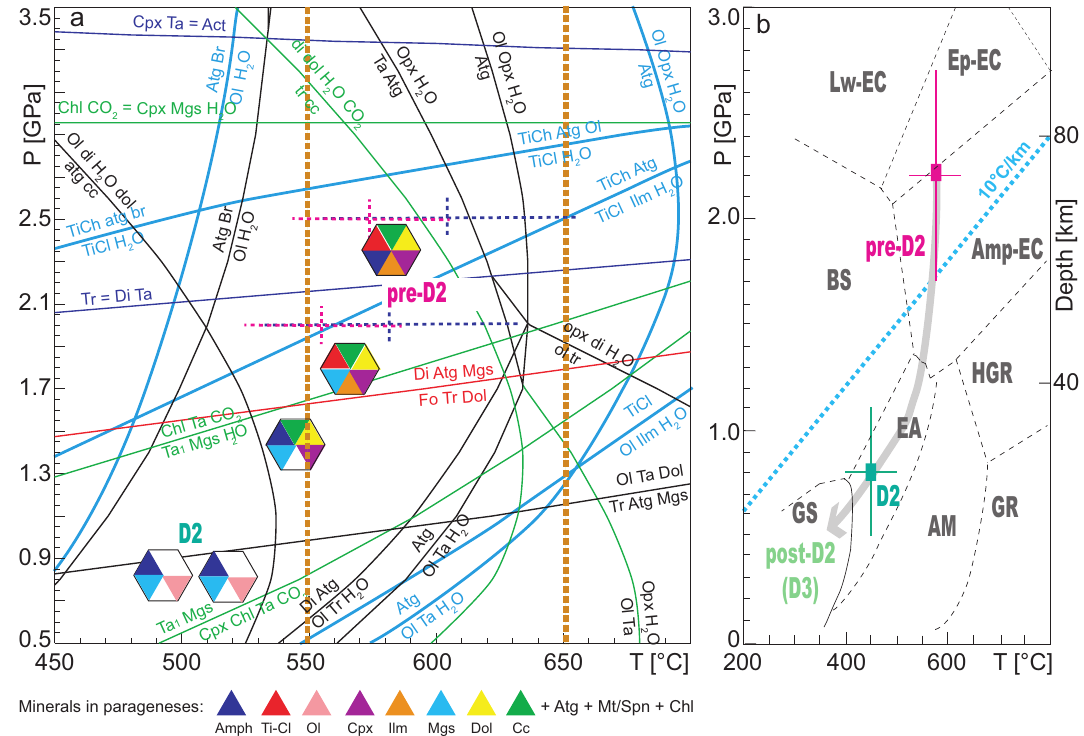
Figure 9. ( a ) PTdt path followed by Chiaves Serpentinite. PT projection is calculated using end-members and THERMOCALC software with a fluid with aCO 2 = 0.1. Reactions in black involve H 2 O, blue ones are H 2 O absent, green ones involve H 2 O and CO 2 and red ones carbonates and silicates without fluid phase. Reactions involving Ti-rich humites, in light blue, are after Shen et al. [20]. Ta1 corresponds to tschermak-talc, i.e., TaTs end-member in THERMOCALC. The orange dashed line reports T conditions calculated using AvT on pre-D2 assemblages of mylonitic serpentinite and serpentinite with Cpx-layer assemblages. Pink and blue dashed crosses are the T conditions calculated using Al and Cr and Cr content of olivine, respectively [131]. Hexagons represent the minerals stable in the different lithologies along a PT path, where Chiaves rocks registered pre-D2, and D2 assemblages. Atg, Mag/Spn and Chl are always present. ( b ) Facies in PT space from Ernst and Liou [135] and PTdt path for Chiaves serpentinite (grey